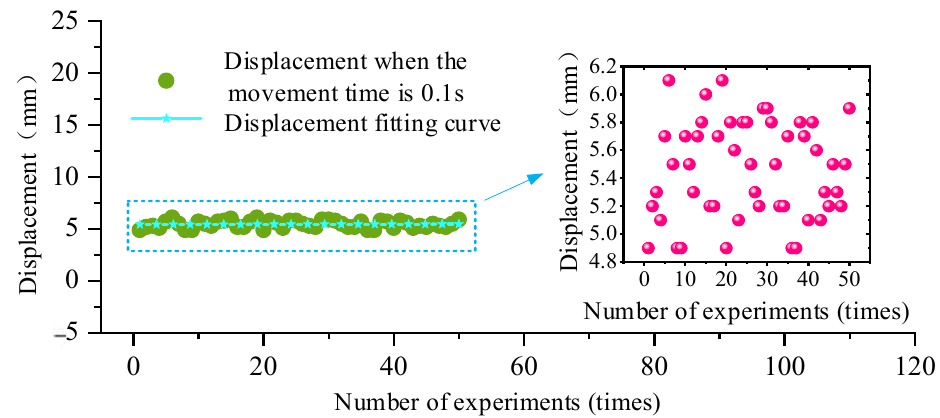
Figure 15. Variation curve of displacement with time during retraction of the balance cylinder of